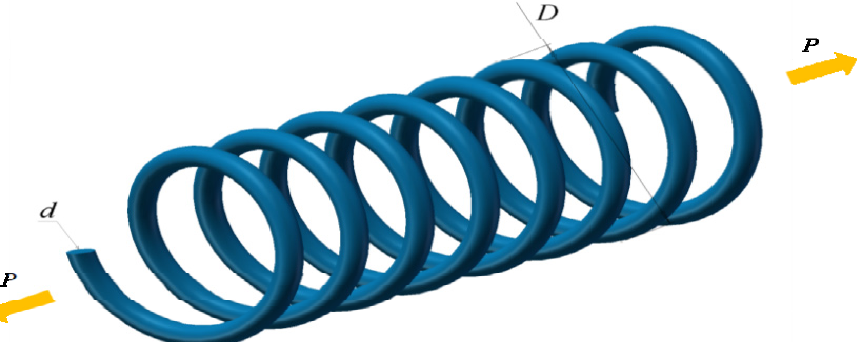
Table 11. Comparison of optimal solutions for the welded beam design problem.